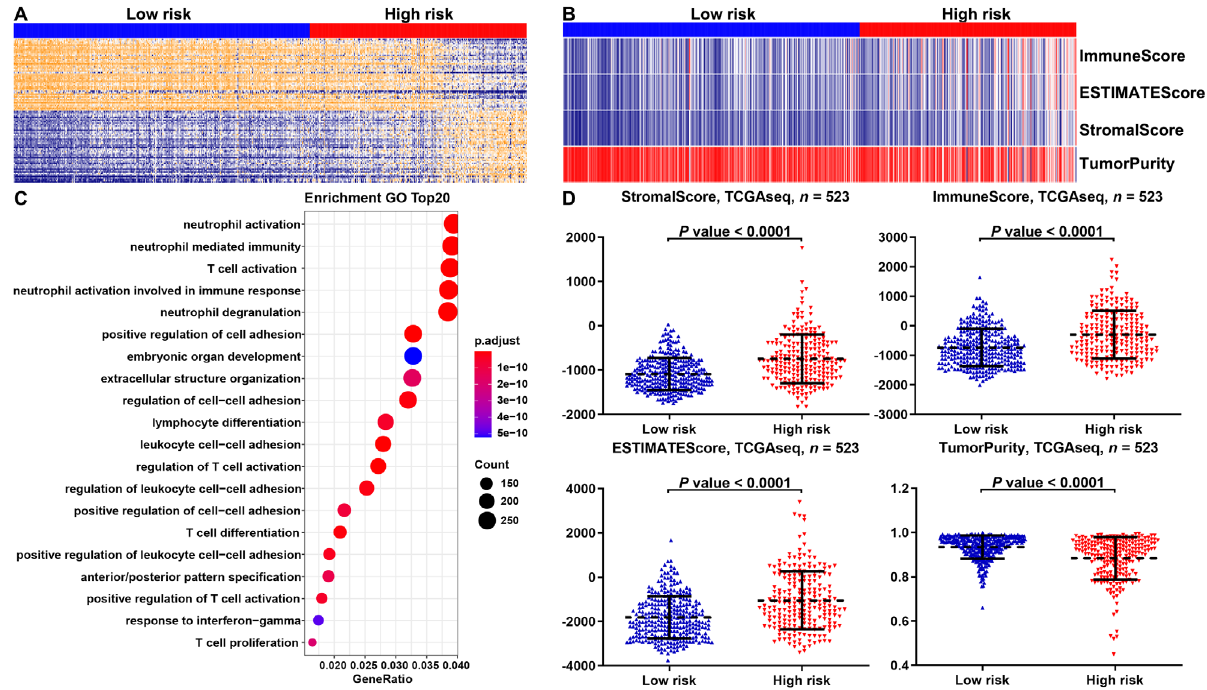
Figure 5. Enrichment analysis and ESTIMATE scores in the low- and high-risk groups of LGGs. (A, B) Enrichment analysis of DEGs in the low- and high-risk groups of LGGs in the TCGA database. The top 20 items were illustrated in the bubblechart; (C) the heat map displayed the distribution features of ESTIMATE scores between the low- and high-risk groups of LGGs in the TCGA database; (D) the scatter plot depicted the results of the ESTIMATE scores between the low- and high-risk groups